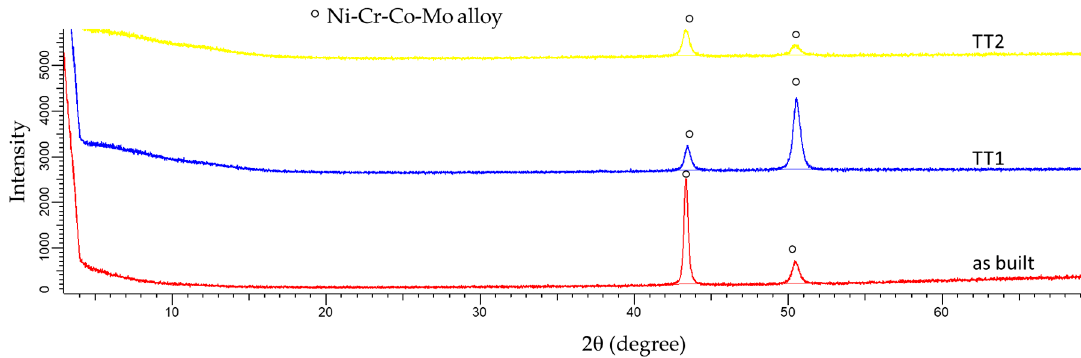
Figure 13. Pattern diffraction of specimens produced in air conditions.